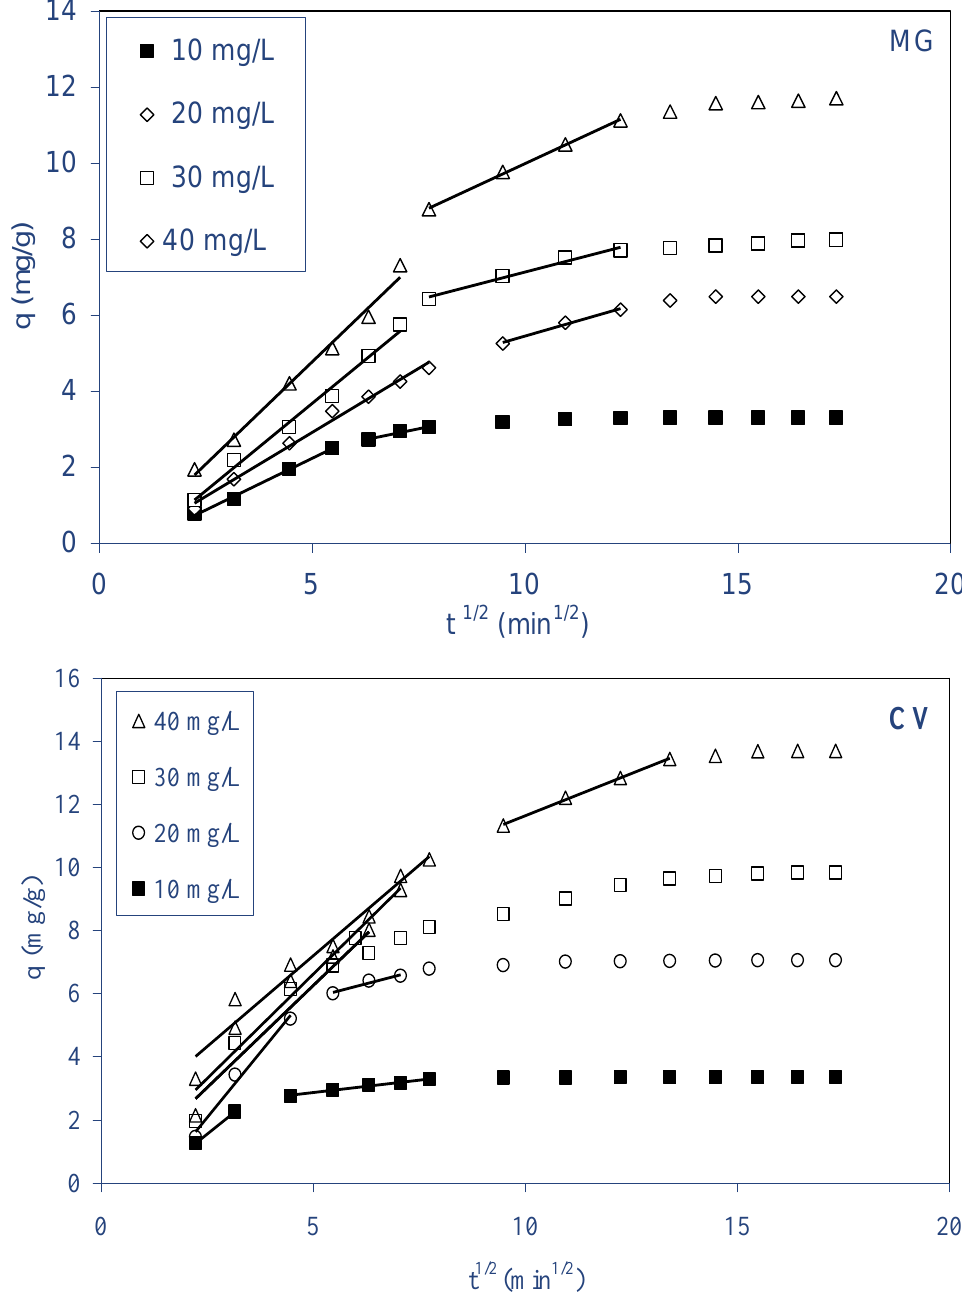
Figure 9. Intraparticle diffusion plots for the biosorption of both dyes on ALP (C 0 : 10–40 mg/L; biosorbent dosage: 2.5 g/L; stirring speed: 400 rpm; pH (MG): 4, pH (CV): 6.5 T: 298 K).